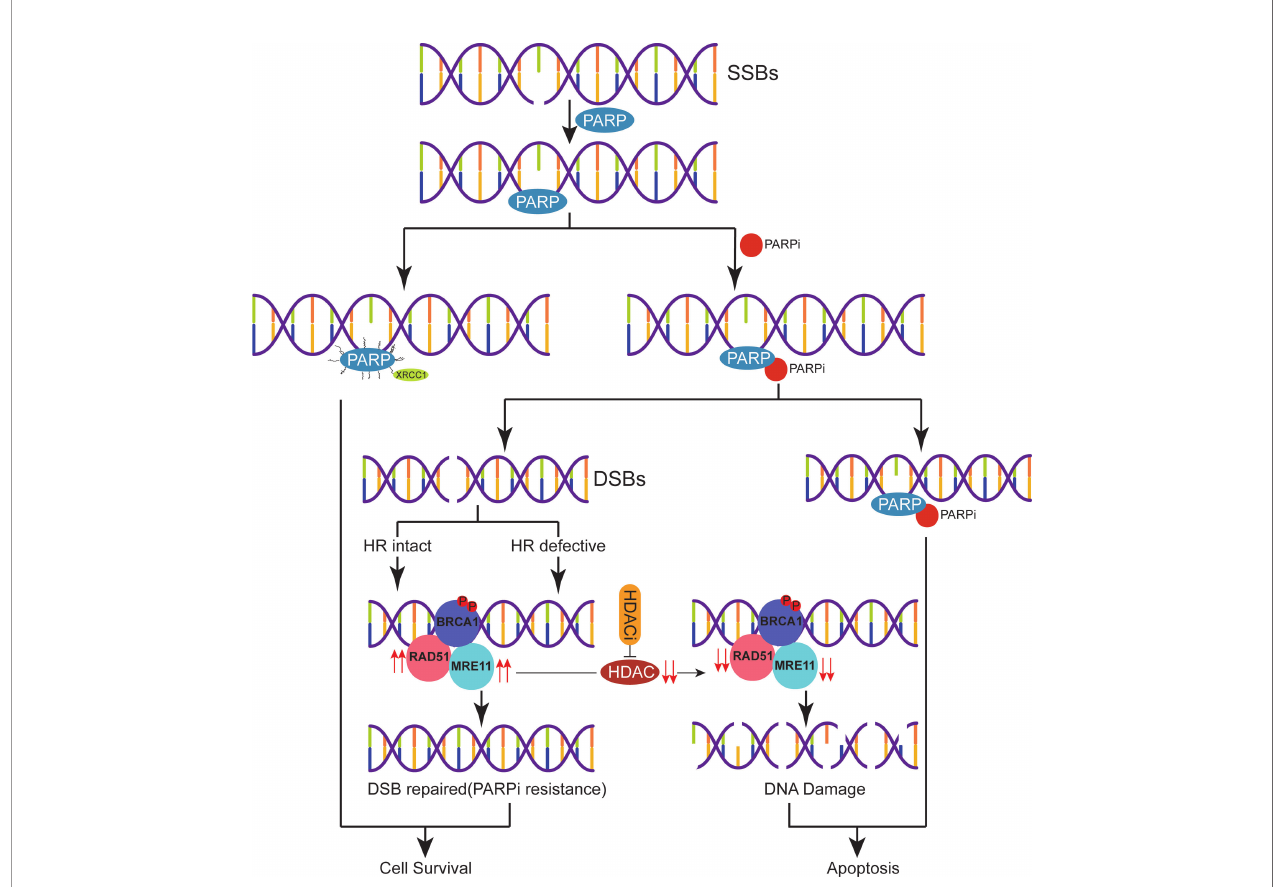
FIGURE 7 | A proposed schematic of PARPi resistance in triple-negative breast cancer. After DNA single-strand breaks (SSBs) occur, PARP binds with the damaged site and recruits related DNA repair proteins to repair the damaged DNA. PARPi can be combined with PARP to inhibit SSB repair leading to apoptosis or process DNA SSBs and initiate homologous recombination (HR) repair. Due to the relative overexpression of the HR repair-related proteins RAD51 and MRE11 in the setting of drug resistance or reduced sensitivity to PARPi, HDACi perpetuates DNA damage by regulating the expression of RAD51 and MRE11, eventually leading to cell